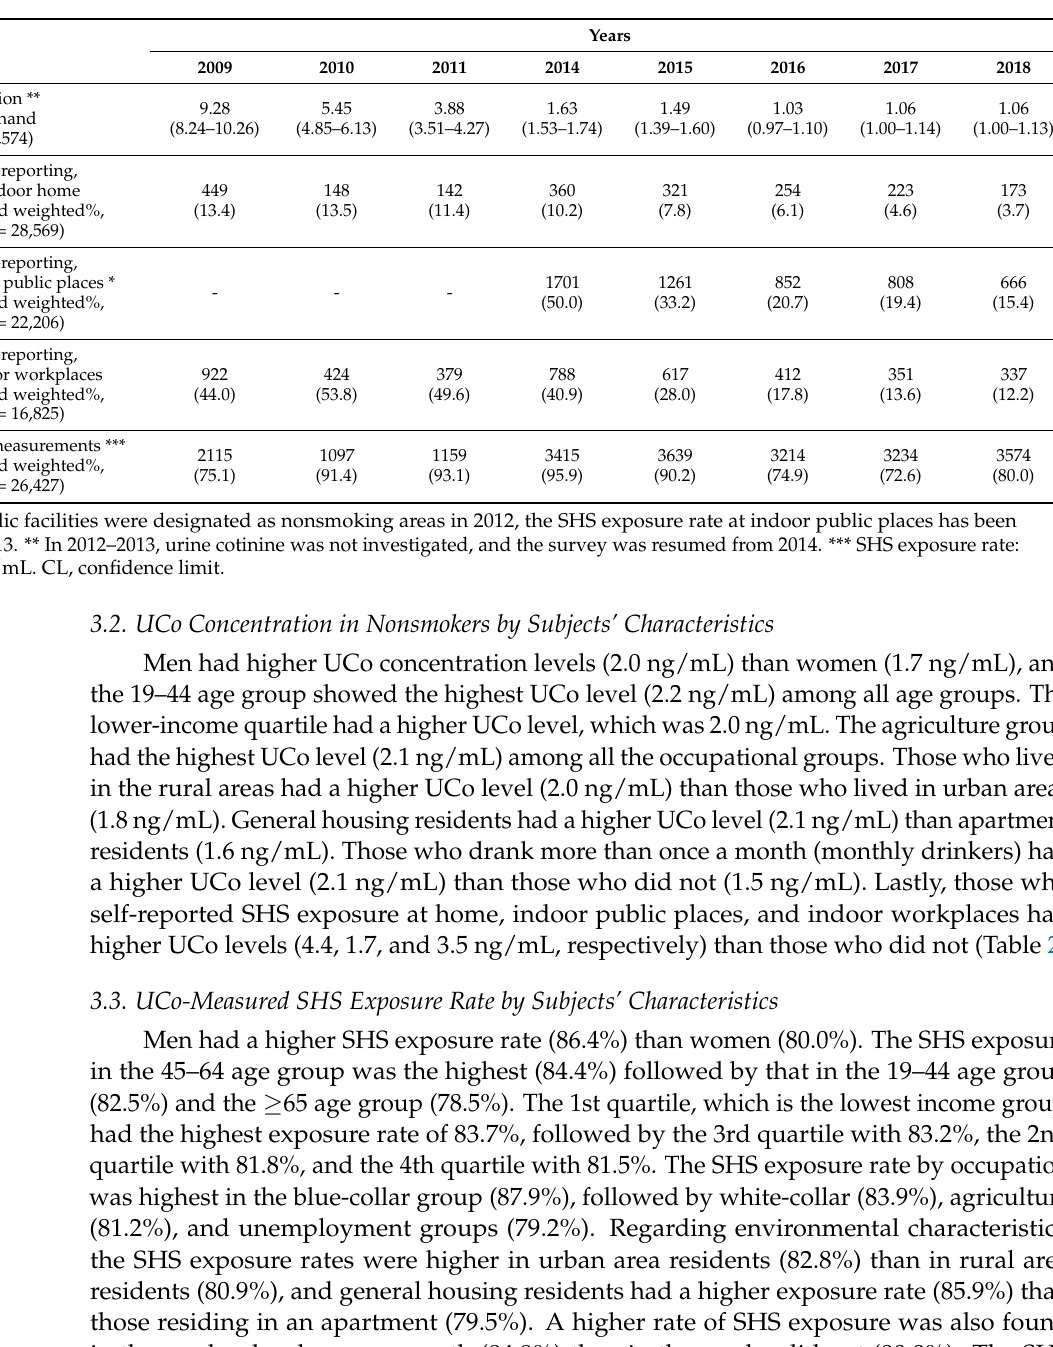
Table 1. Urine cotinine concentrations and SHS exposure rate by